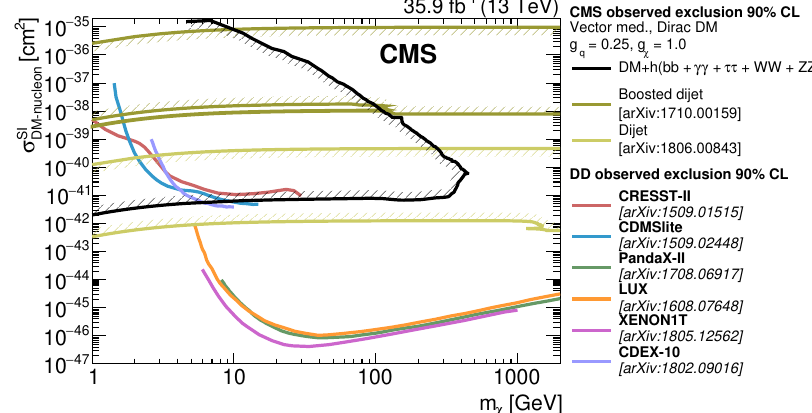
Figure 11 . The upper limits at 90% CL on the DM-nucleon spin-independent scattering cross section (cid:27) SI , as a function of m . Results obtained in this analysis are compared with those (cid:31)